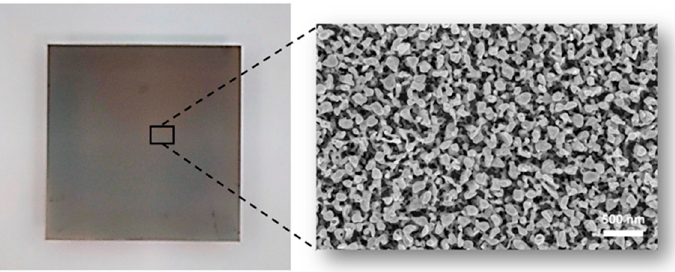
Figure 6. Digital photograph of SERS substrate fabricated on a 15 × 15 mm 2 glass coverslip and SEM image of the nanostructured Ag film, exhibiting the typical coral-like morphology.